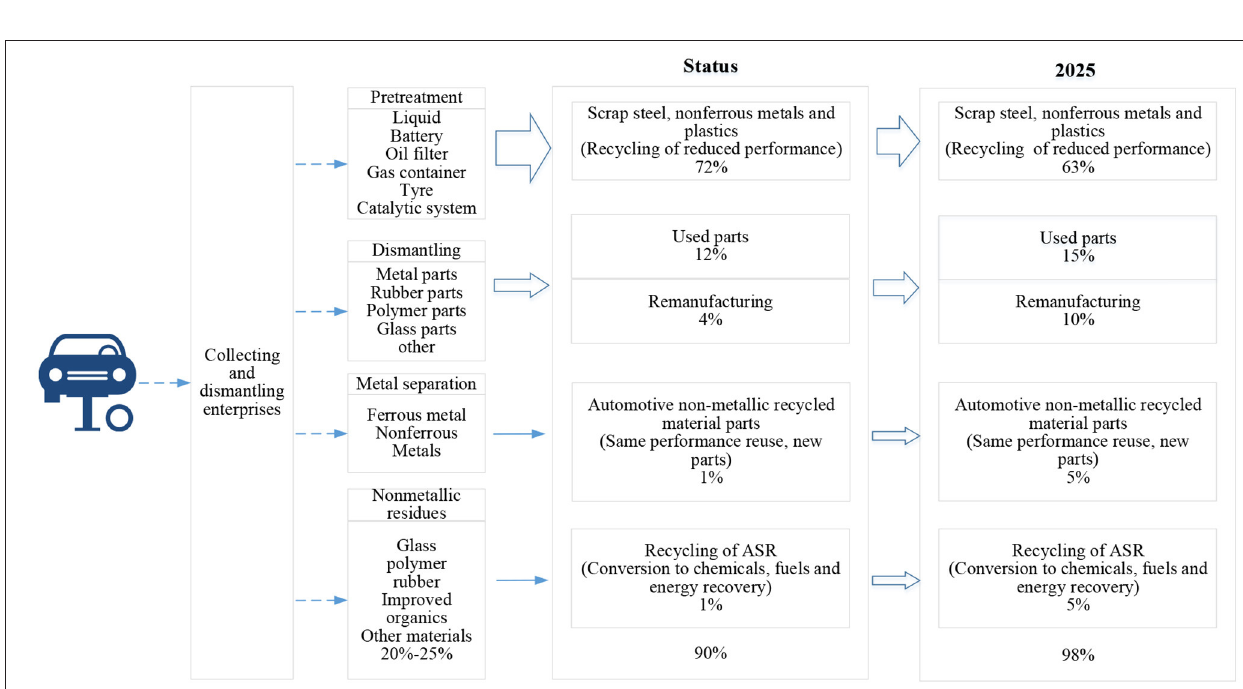
FIGURE 5 | ELV parts and material recycling ways in